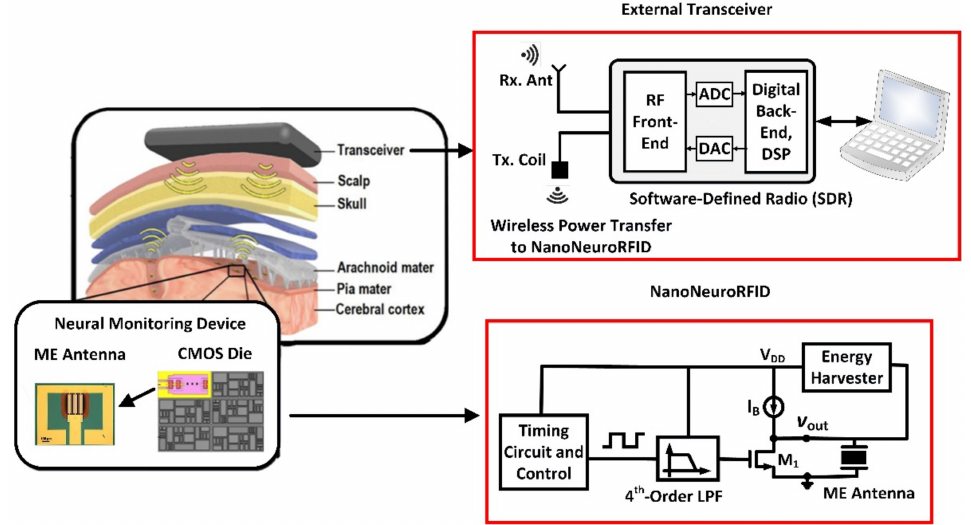
Figure 2. Illustration of magnetic field sensing with an ME antenna, nanoscale neural radio frequency identification (NanoNeuroRFID), and a software-defined radio (SDR). Acronyms: